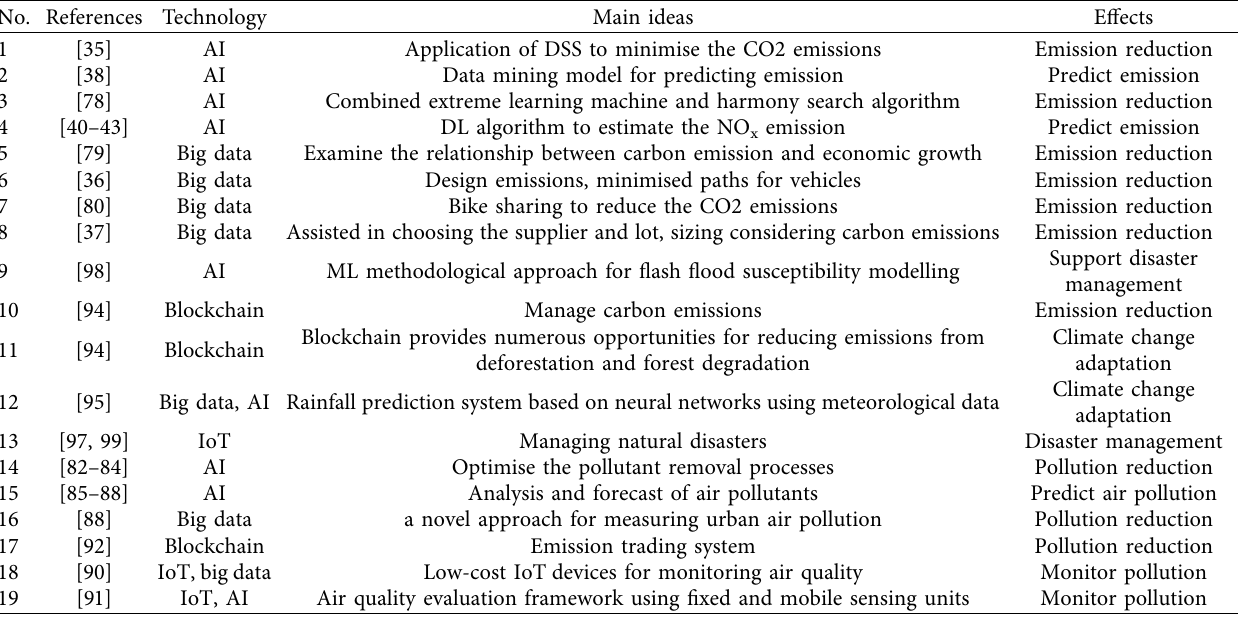
Table 4: Applications of digital technology in pollution prevention and control.